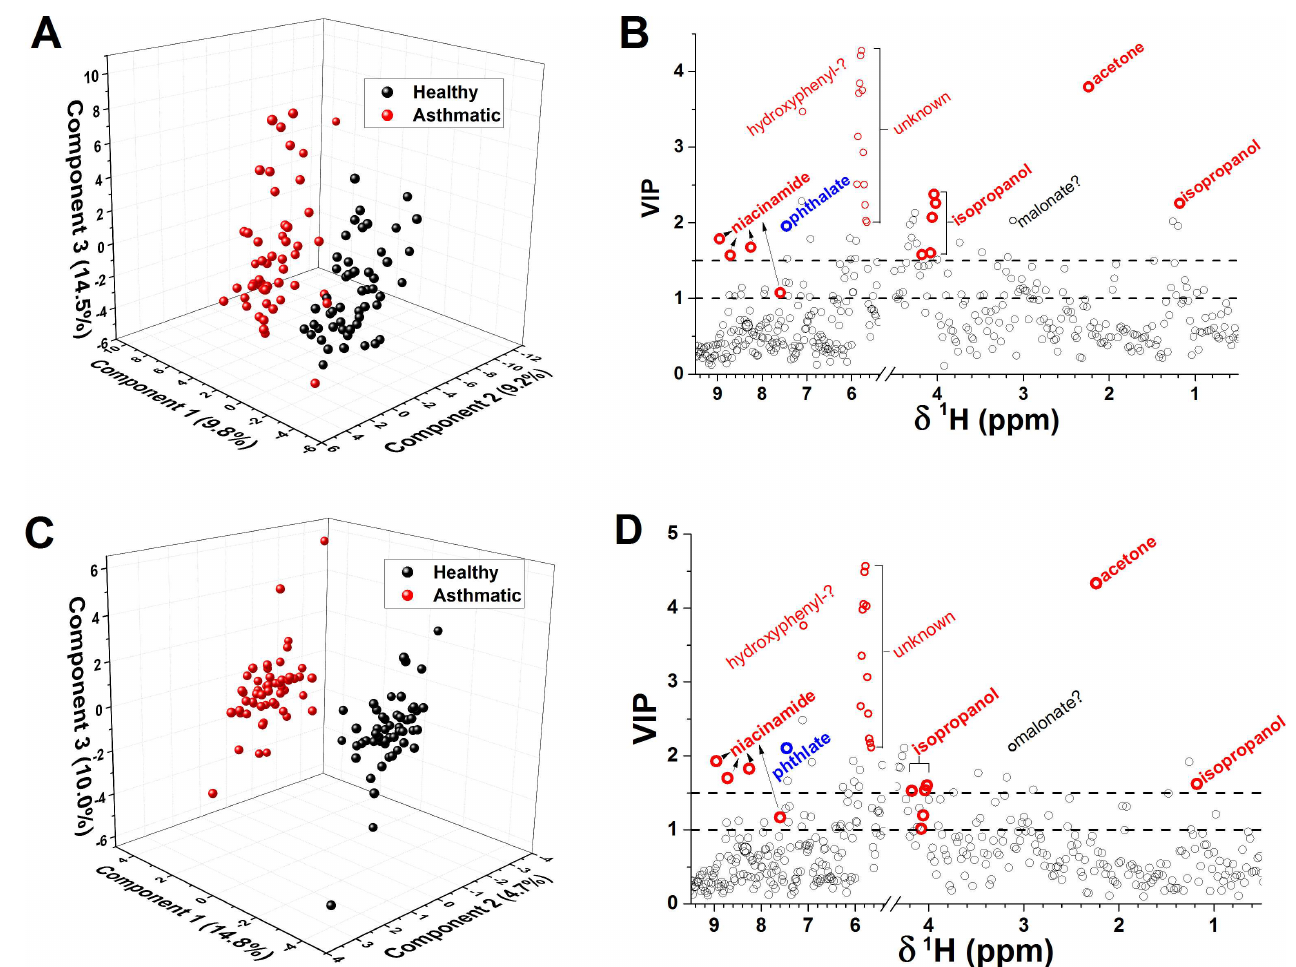
Fig 2. Orthogonal signal-corrected statistical results for the preprocessed spectra of EBC from 53 cats before and after induction of allergic asthma. Panels (A,B) show results from OSC-PLS-DA. Panels (C,D) show results from multi-level OSC-PLS-DA. (A,C) Scores are plotted, using the three largest principalcomponents, for specimens collectedbefore (black) and after inductionof asthma (red). (B,D) The variable importancein projection(VIP) plots suggest the spectral features that most distinguishthe experimental asthma from the health of the cats. As VIP values rise above 1.0, they imply increasingdiagnostic significance [54]. Biomarkers increasedby feline asthma are labeledred. A marker decreasedby the experimental asthma is labeledblue. The weakness of the tentatively assignedNMR peak of malonate (labeledin gray) diminishes its diagnosticvalue belowthat impliedby the VIP